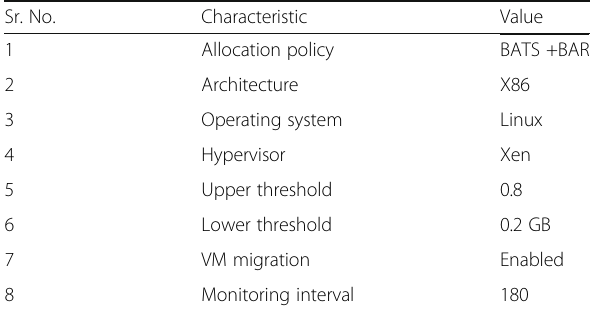
Table 11 Data center configuration details Sr. No.